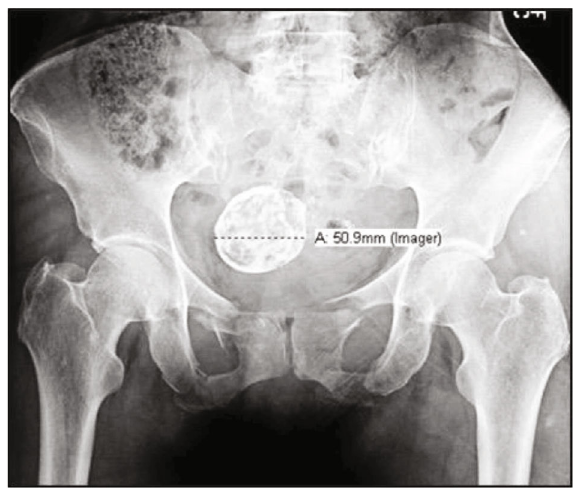
Figure 1: Initial anteroposterior pelvis X-ray showing bilateral pubic rami fractures and a large uterine fi broid, in a 65-year-old patient pedestrian struck by a motor vehicle.